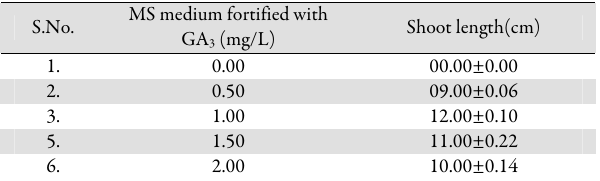
Table 3. Effect of GA 3 on elongation of micro shoots of Physalis angulata L. at two weeks of culture